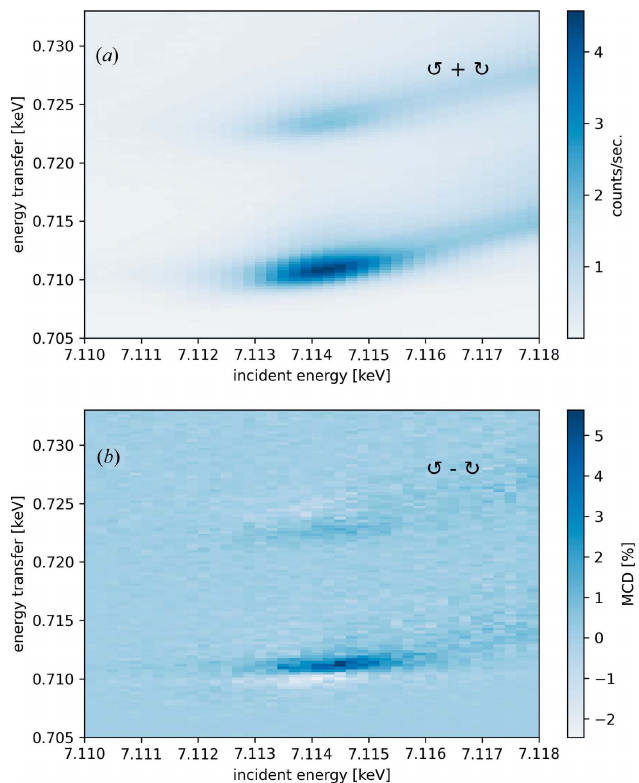
Figure 5 ( a ) An RXES map of an NdFeB permanent magnet measured at the Fe K -edge (resulting from the sum of two RXES maps measured with circular-left and circular-right polarized photons). ( b ) RXES–MCD shown as a difference map (in %) of the two RXES